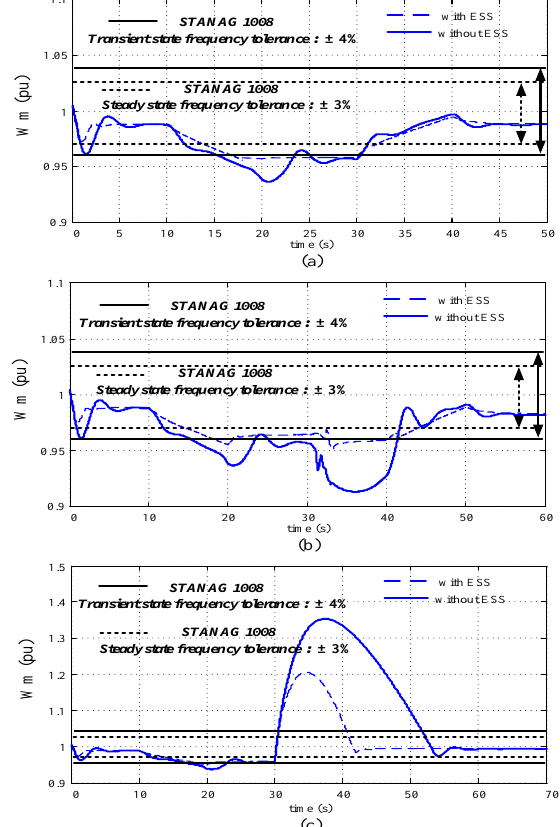
Figure 11. Simulation results with the energy storage system: ( a ) Acceleration and deceleration; ( b ) Loss of prime mover; ( c ) Full propulsion load rejection. Table 2. Electrical characteristics according to the operation conditions.